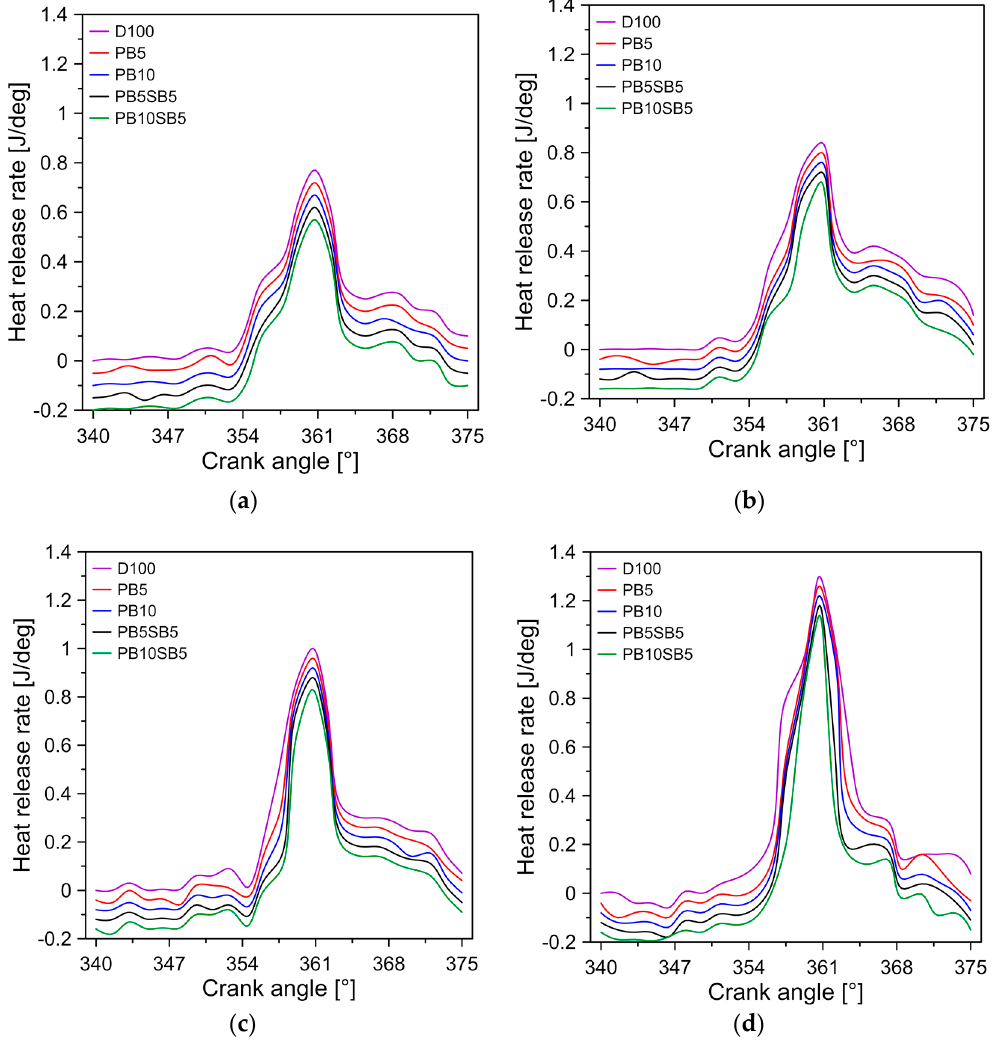
Figure 6. Influence of fuel on heat release rate for ( a ) mode A, ( b ) mode B, ( c ) mode C, and ( d ) mode D.